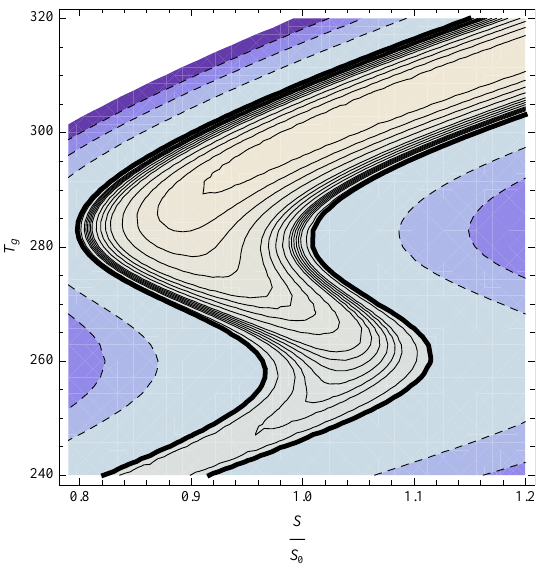
Fig. 9. Contour plot of the entropy production rate as a function of the solar constant (normalized by its present-day value) and the surface temperature T g (in K). Negative contour lines are dashed, positive contour lines are solid and the null contour line is the thick solid line. Shades of blue represent negative values of the entropy production